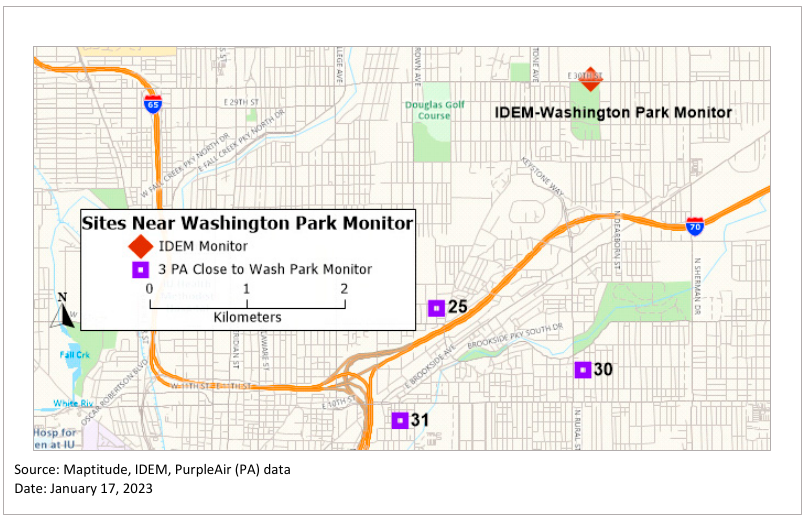
Figure 2. Sensors nearest to Indiana Department of Environmental Management (IDEM) regula- tory